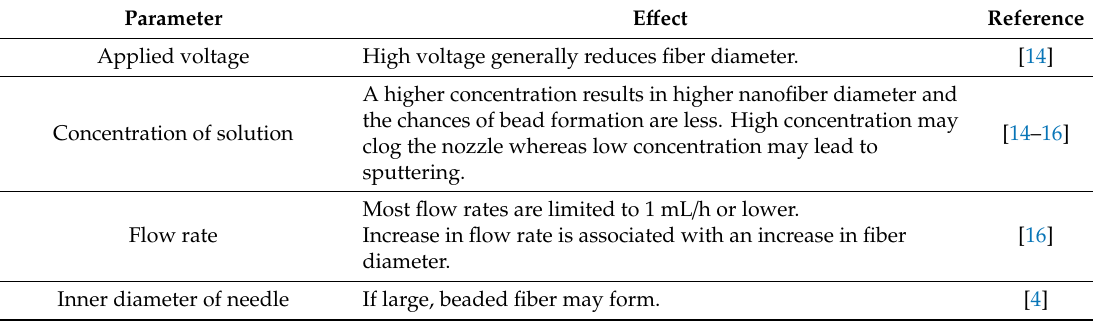
Table 1. E ff ect of various parameters on the properties of electrospun nanofibers. Table 1. Effect of various parameters on the properties of electrospun nanofibers. Parameter E ff ect Parameter Effect Applied voltage